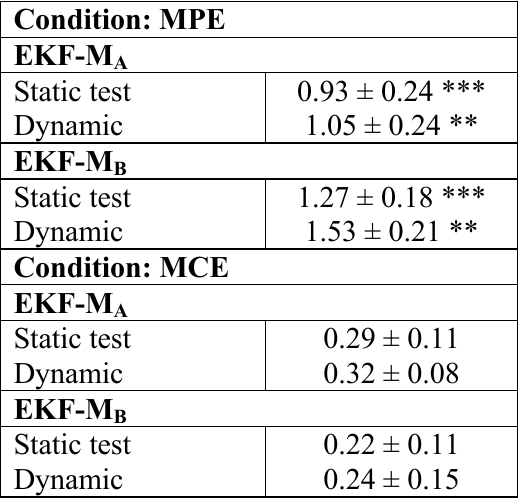
Table 3. Monte Carlo simulation results (mean ± SD); ** SSD at p < 0.01; *** SSD at p < 0.001.